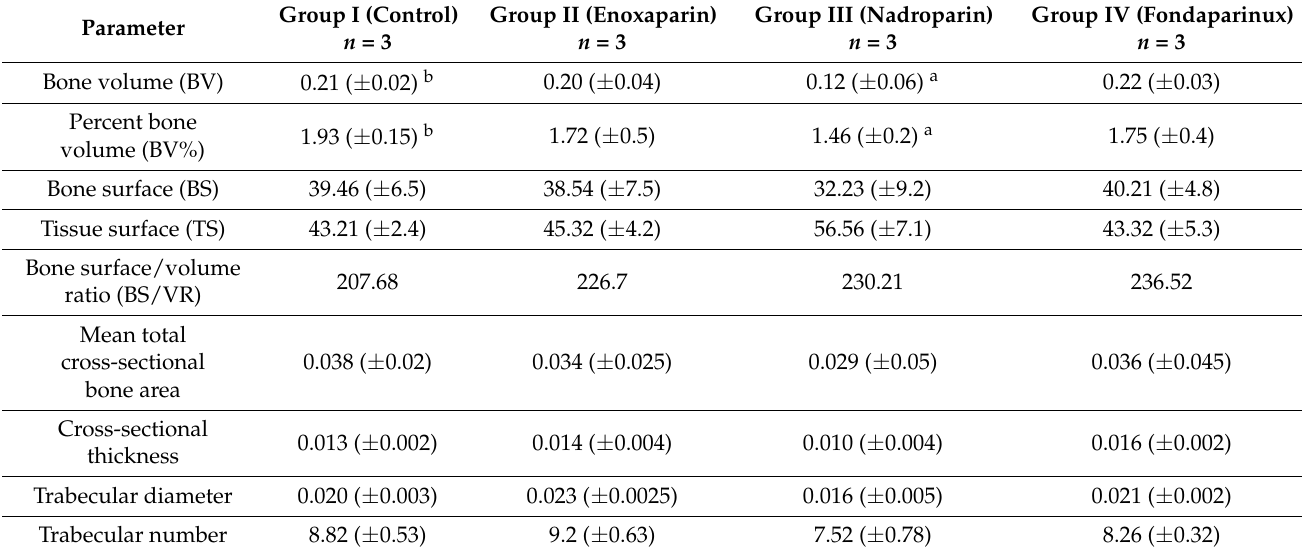
Table 1. Results of micro-CT examination expressed in mean ( ± standard